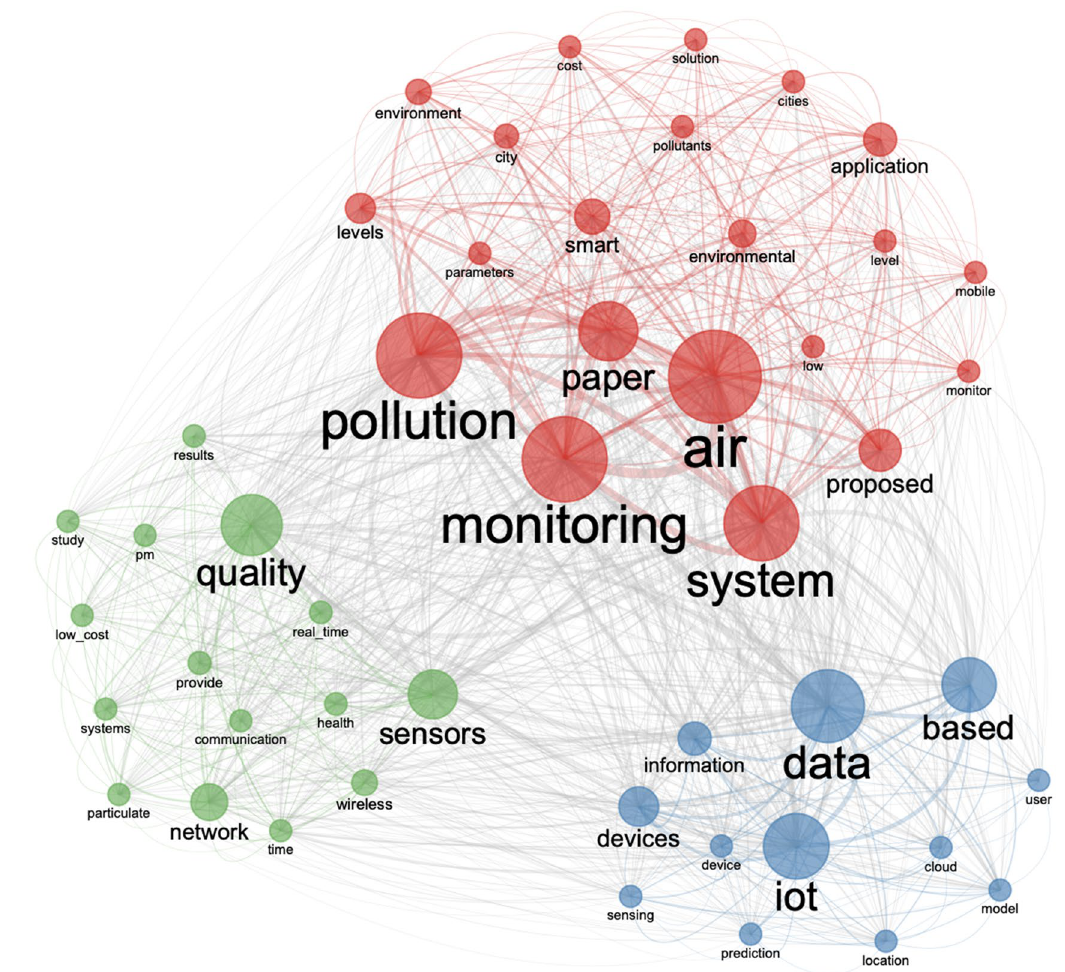
Figure 1. Network visualization of frequently occurring terms within the existing literature related to keywords “Internet of Things” and “Air pollution monitoring”.